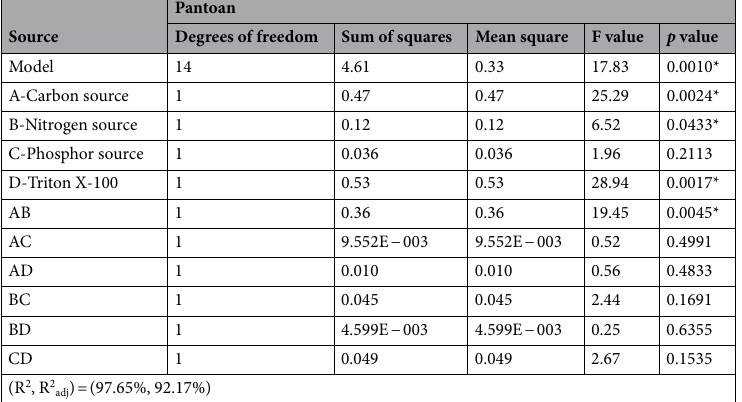
Table 5. Analysis of Variance (ANOVA) statistics for Pantoan using sugar beet molasses media. *Significant model